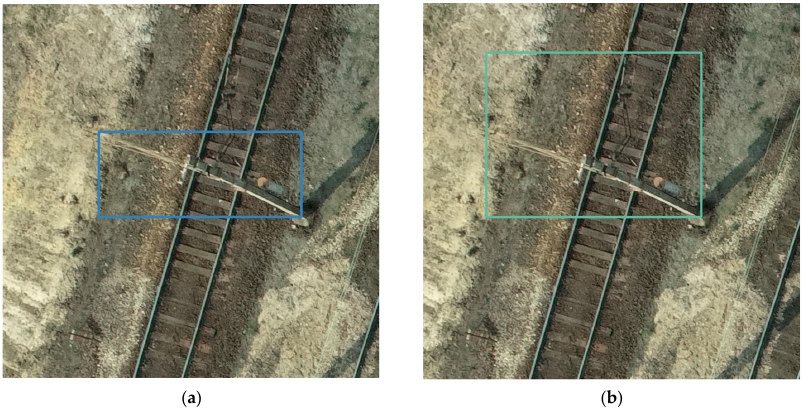
Figure 16. An example of a training dataset for traction poles with IoU = 0.48; ( a ) the bounding box generated from DIM point clouds; ( b ) ground-truth bounding box from TLS point cloud.